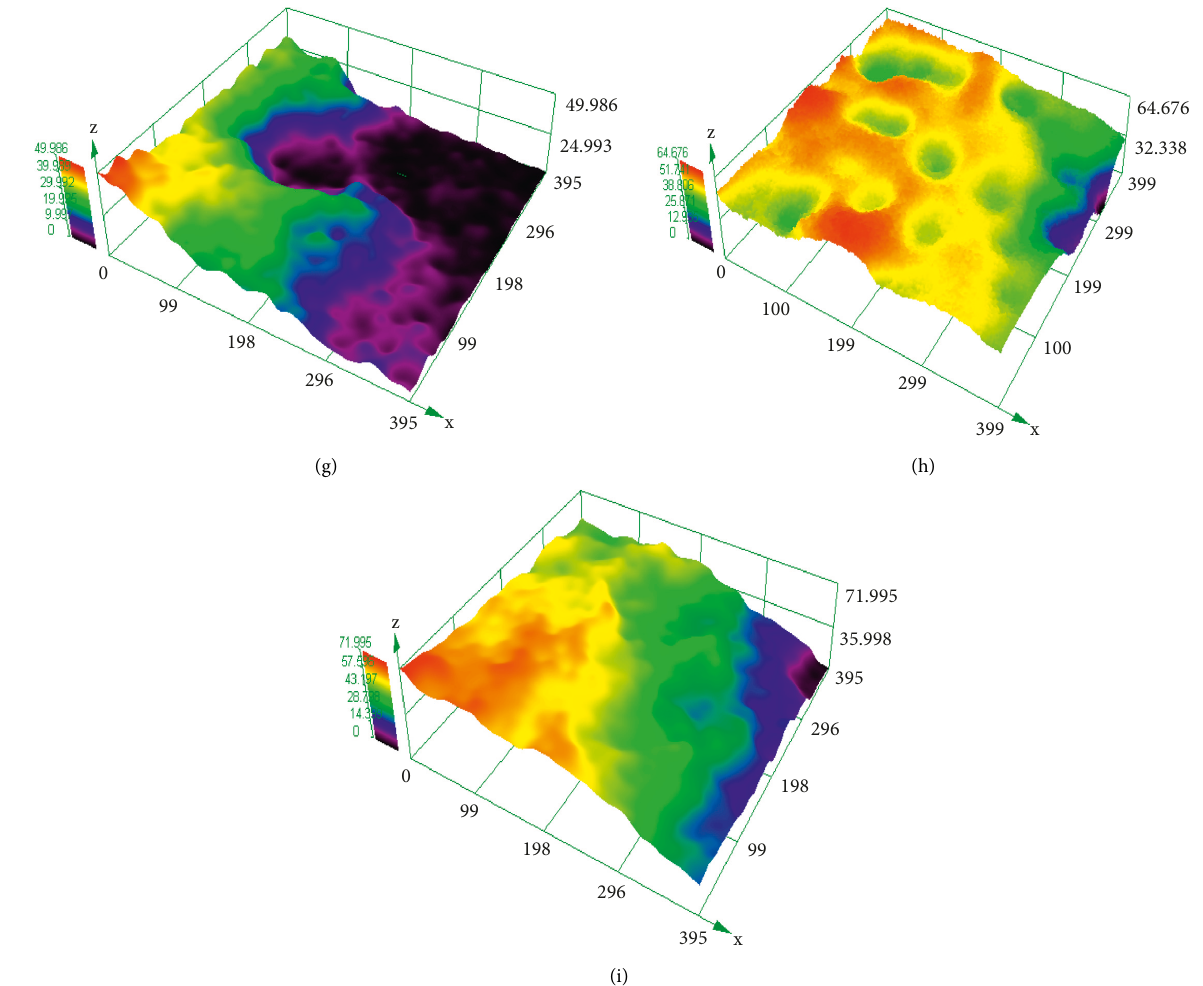
Figure 6: Surface morphology of corroded weathering steel (scale bar unit: μ m). (a) 0h. (b) 1 h. (c) 2h. (d) 4h. (e) 8h. (f) 12h. (g) 24h. (h) 48 h. (i) 72 h.